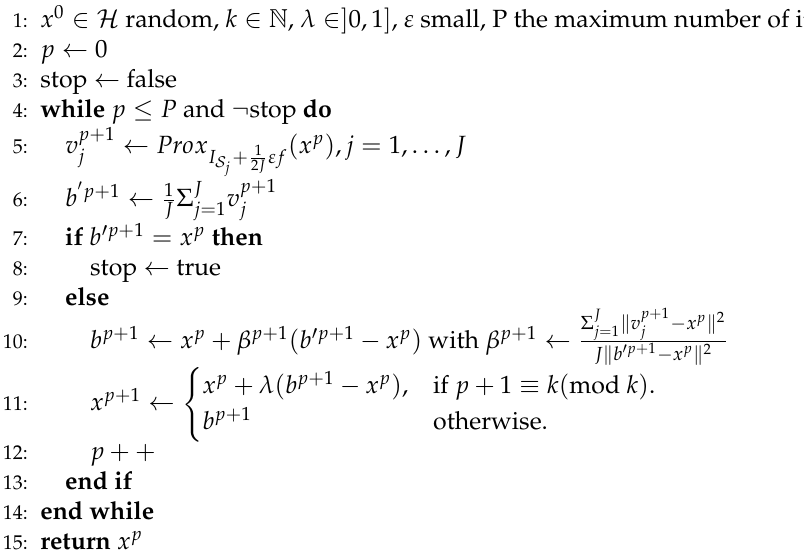
Algorithm 2 Pierra’s algorithm to solve